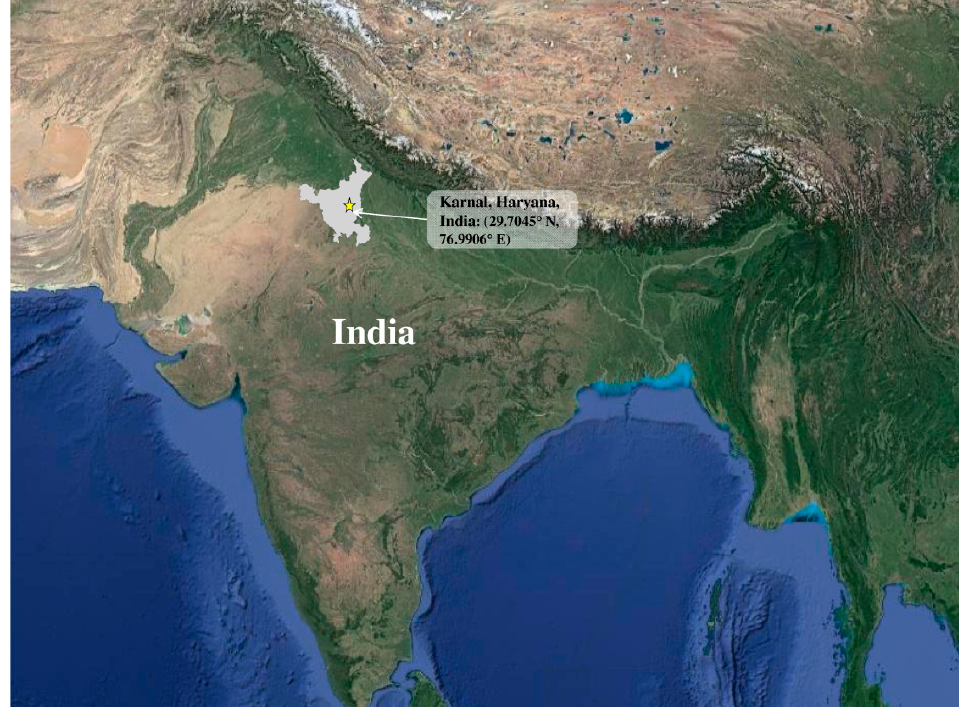
Figure 2. Location of the experimental site.